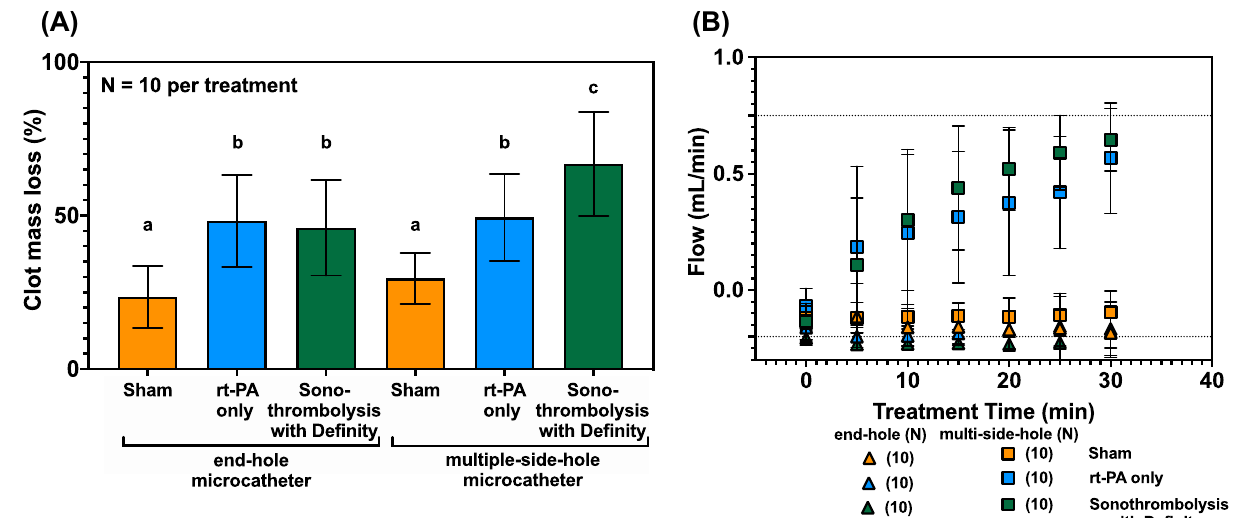
Figure 1. In vitro percent clot mass loss ( A ) and flow ( B ) for human whole blood clots with n = 10 for each treatment through each microcatheter. The end-hole microcatheter was positioned at the proximal face of the clot, and the multiple-side-hole microcatheter crossed the clot axially. Flow measurements spanned -0.2 mL/ min for a fully occluded APA mimic (retrograde flow due to the treatment infusion) to 0.75 mL for a fully recanalized APA mimic (dotted lines). A one-way ANOVA was performed and significance was shown using compact letter display to identify statistically equivalent